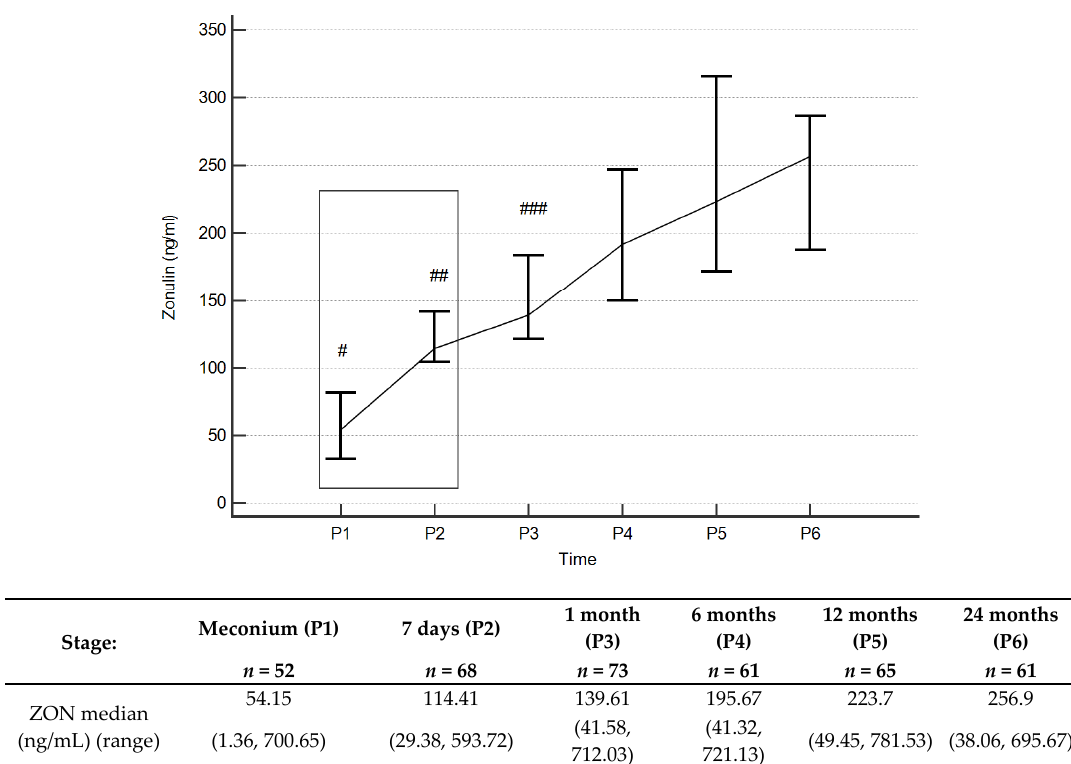
Figure 2. Zonulin (ZON) concentrations (median) over time. Legend: Error bars represent 95% confidence intervals for medians. For Kruskall–Wallis test p < 0.000001. Conover’s post-hoc analysis: